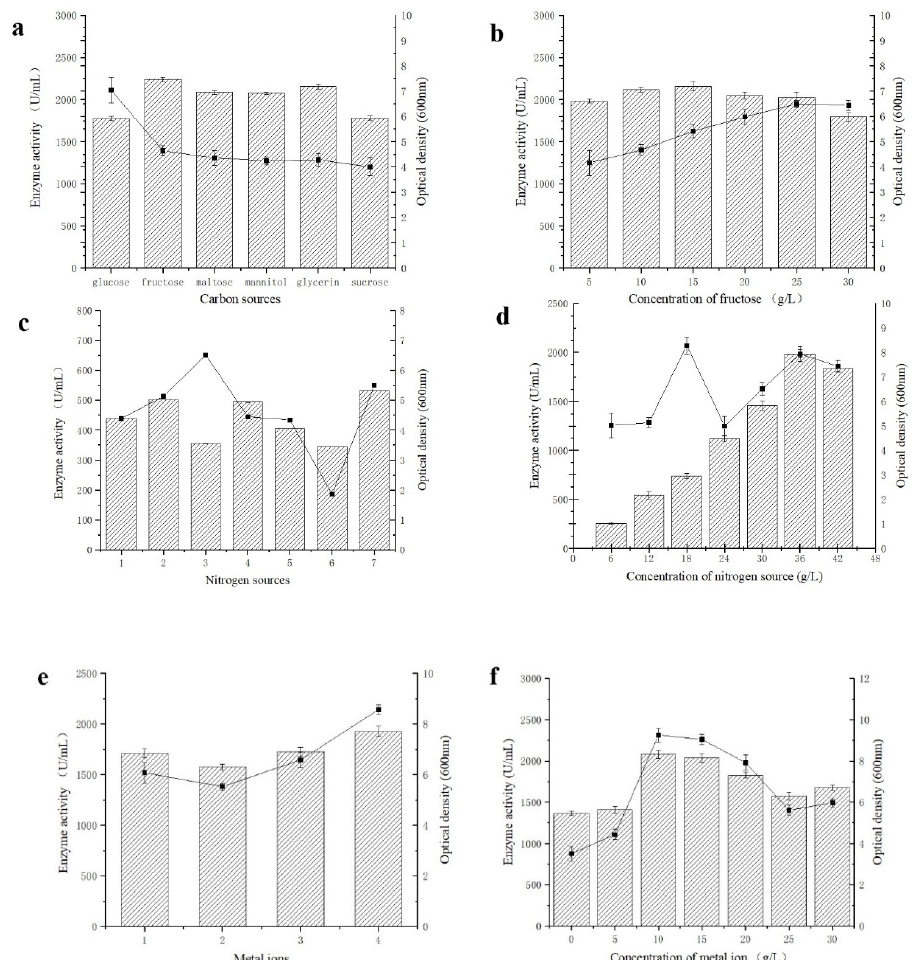
Figure 7. Optimization of the growth media for recombinant expression of collagenase in B. subtilis WB600. The histogram represents the activity of recombinant collagenase and the line represents the bacterial growth. ( a ) Effect of carbon sources on the enzyme activity and cell growth. ( b ) Effect of concentration of fructose on the enzyme activity and cell growth. ( c ) Effect of nitrogen sources on the enzyme activity and cell growth. 1, beef paste; 2, ammonium sulphate; 3, yeast powder; 4, peptone; 5, urea; 6, gelatin; 7, mixture of peptone and yeast powder. ( d ) Effect of the concentration of nitrogen source on the enzyme activity and bacterial growth. ( e ) Effect of metal ions on the enzyme activity and cell growth. 1, Zn 2+ ; 2, Mg 2+ ; 3, Na 2+ ; 4, Ca 2+ . ( f ) Effect of concentration of the Ca 2+ metal ion on enzyme activity and bacterial growth. The data are presented as mean ± standard deviation from three independent experiments.